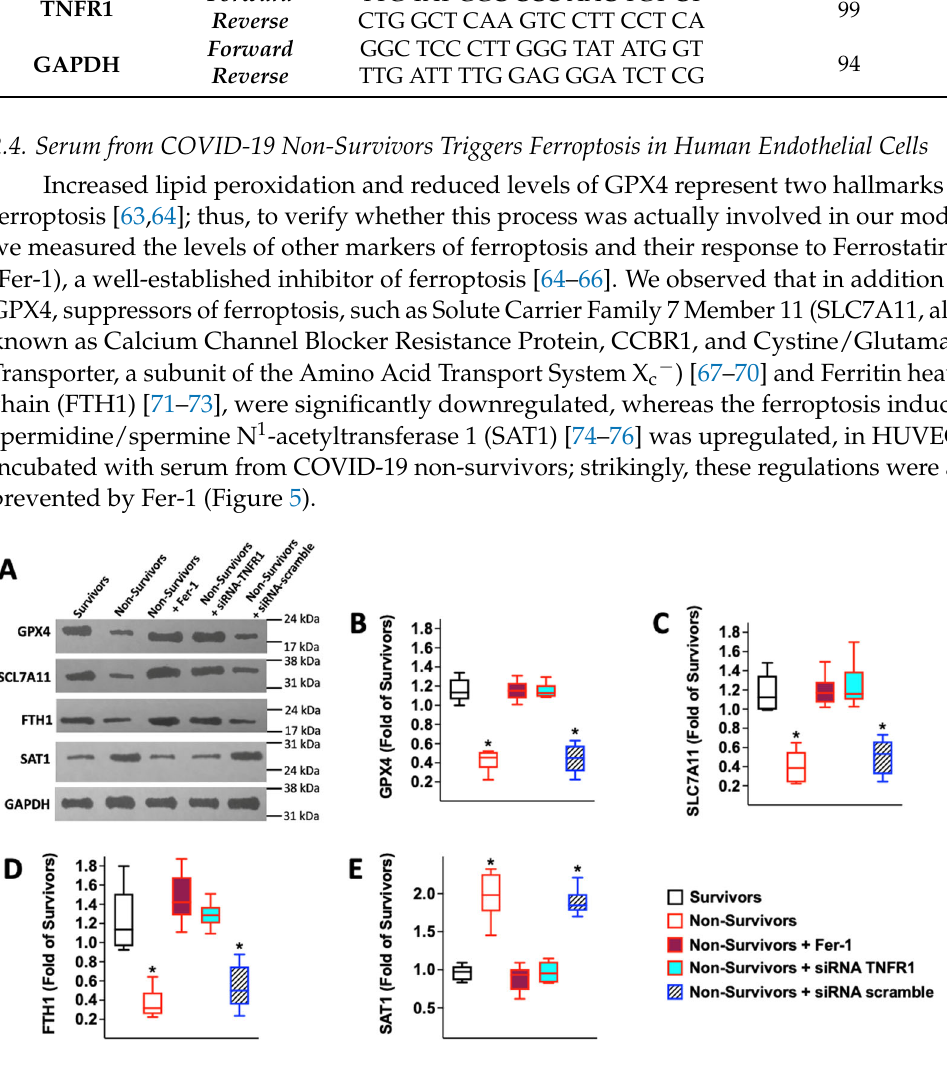
Figure 5. COVID-19 serum from non-survivors regulates ferroptosis via TNFR1 in HUVECs. Representative immunoblots are shown in panel ( A ), quantified in panel ( B ) (GPX4), ( C ) (SCL7A11), ( D ) (FTH1), and ( E ) (SAT1). All experiments were performed at least in triplicate; the box-and- whiskers graphs show the median and the 5th–95th percentiles; *: p < 0.01 vs. Survivors.